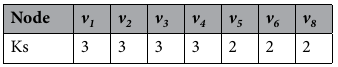
Table 2. Ks of v 1 and adjacent nodes.